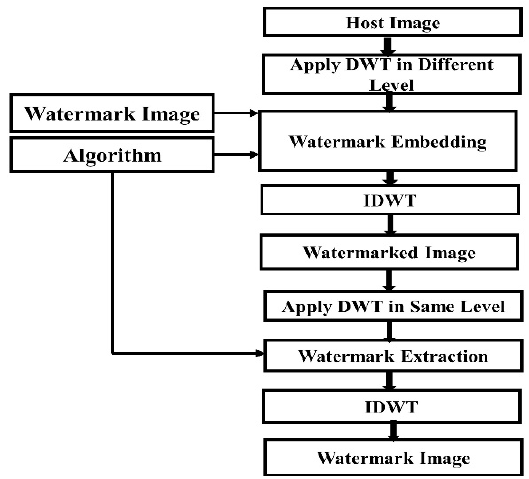
Figure 14. Watermark embedding and extraction in a Discrete Wavelet Transform (DWT) domain.